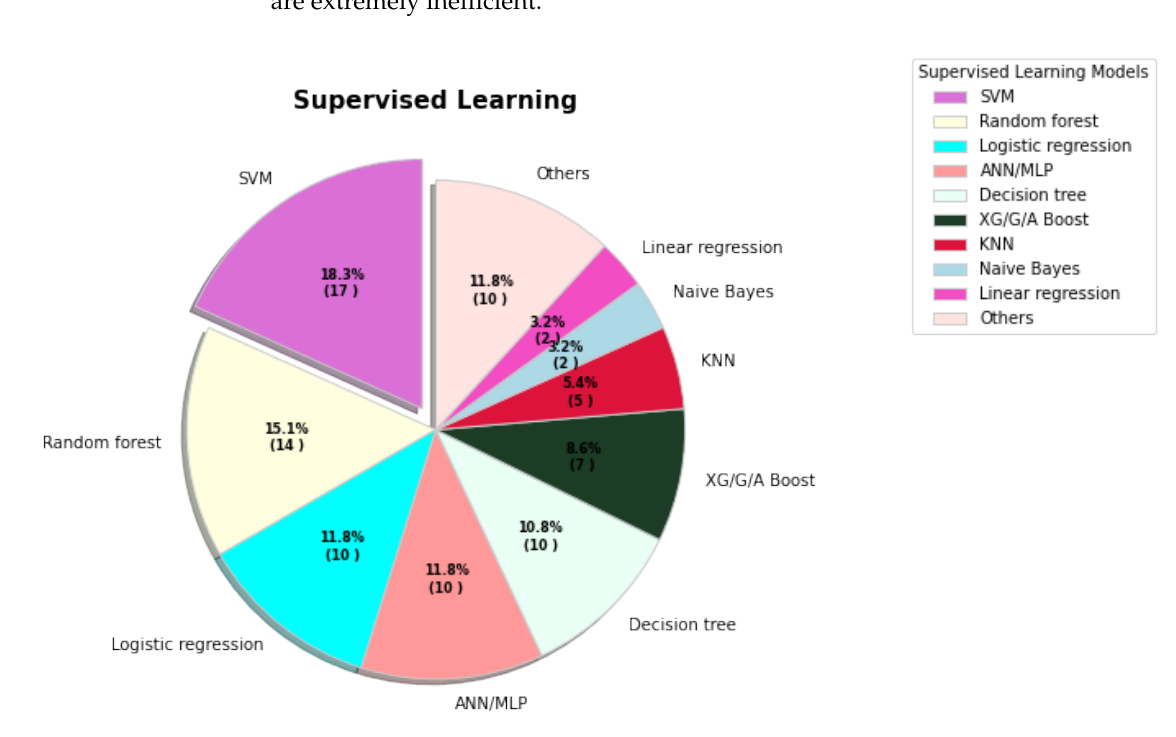
Figure 3. The percentages of various supervised learning models being used for COVID-19